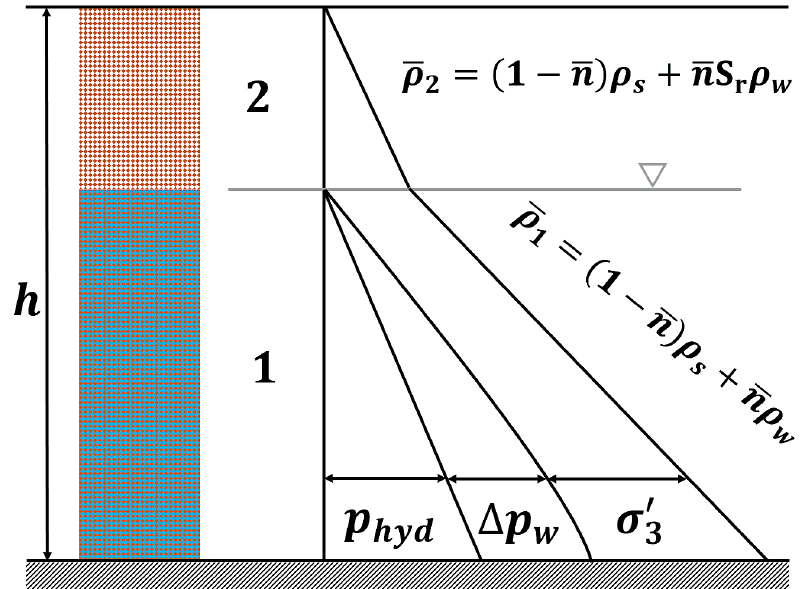
Figure 3. Pore-water pressure distribution in solid–fluid mixture of total height h . The lower layer (Layer 1) is fully saturated, whereas the upper layer (Layer 2) could be partially saturated or dry ( S r = 0 )